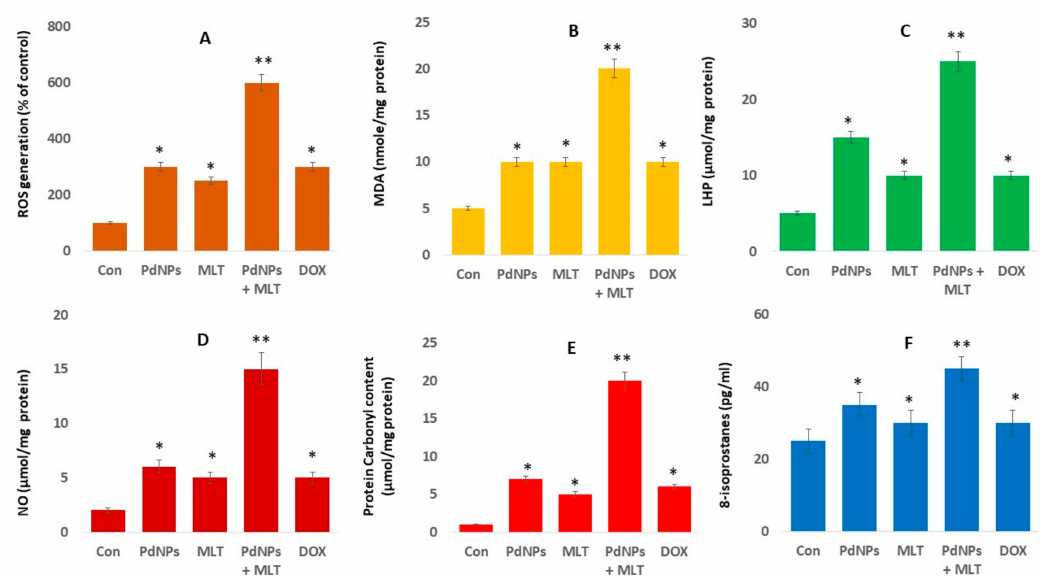
Figure 6. PdNPs + MLT increased production of oxidative stress markers. A549 cells were incubated with PdNPs (2.5 µ M), MLT (0.75 mM), PdNPs and MLT (2.5 + 0.75 mM), or DOX (5.0 µ M)